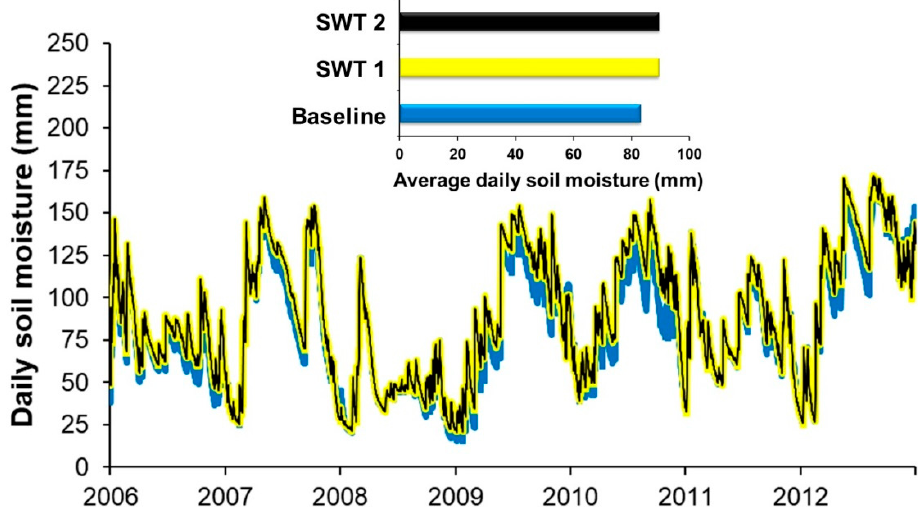
Figure 16. Daily soil moisture for the Santa Catalina stream basin for the 2006–2012 period under three different scenarios: baseline scenario (blue), SWT1 scenario (yellow), and SWT2 scenario (black).